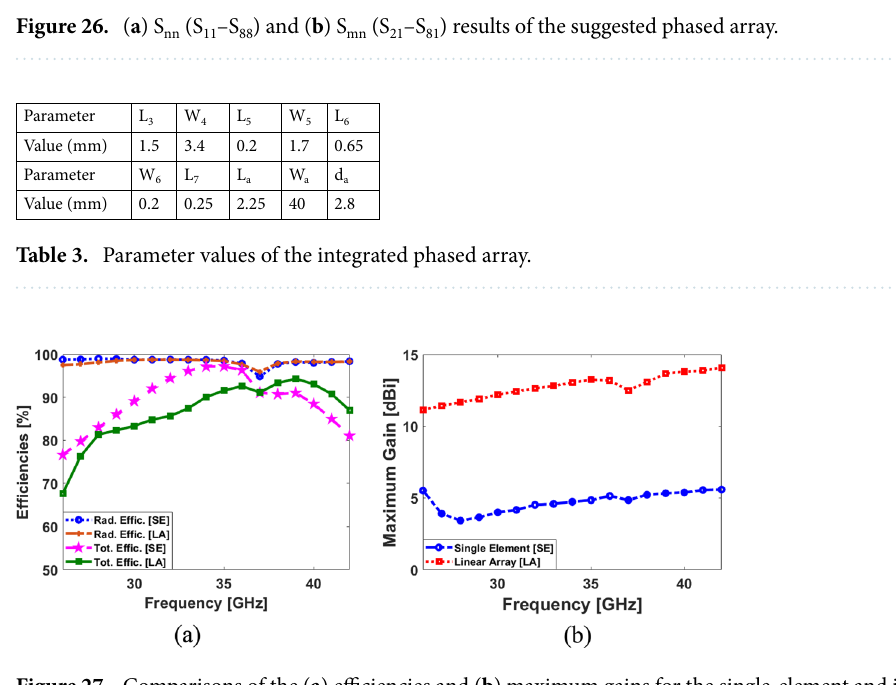
Figure 27. Comparisons of the ( a ) efficiencies and ( b ) maximum gains for the single-element and its linear phased